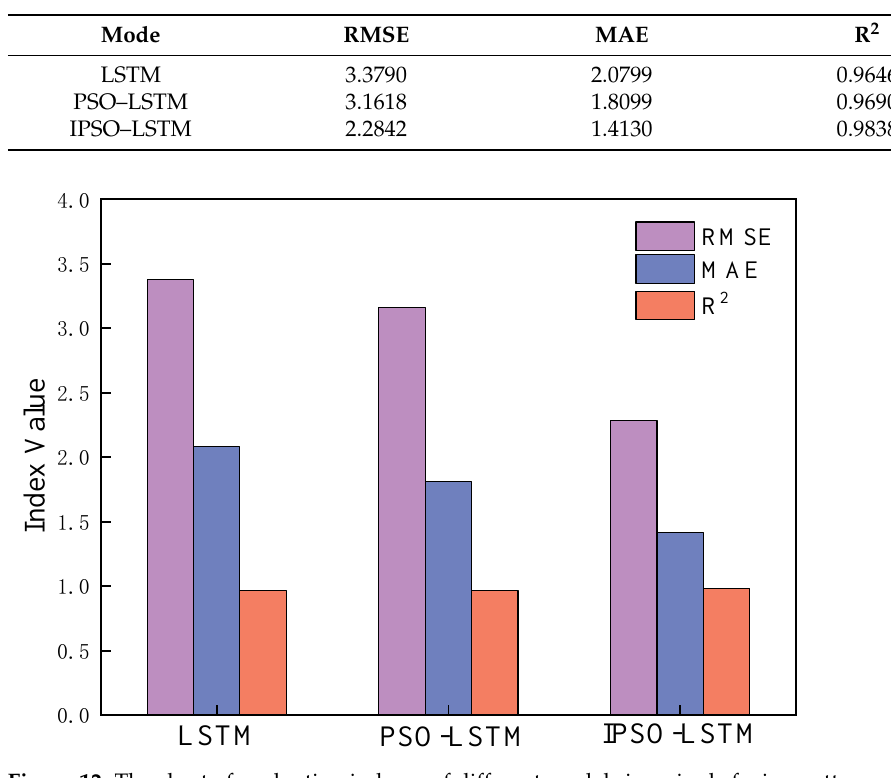
Table 4. Evaluation indexes of IPSO – LSTM in different fusion patterns.